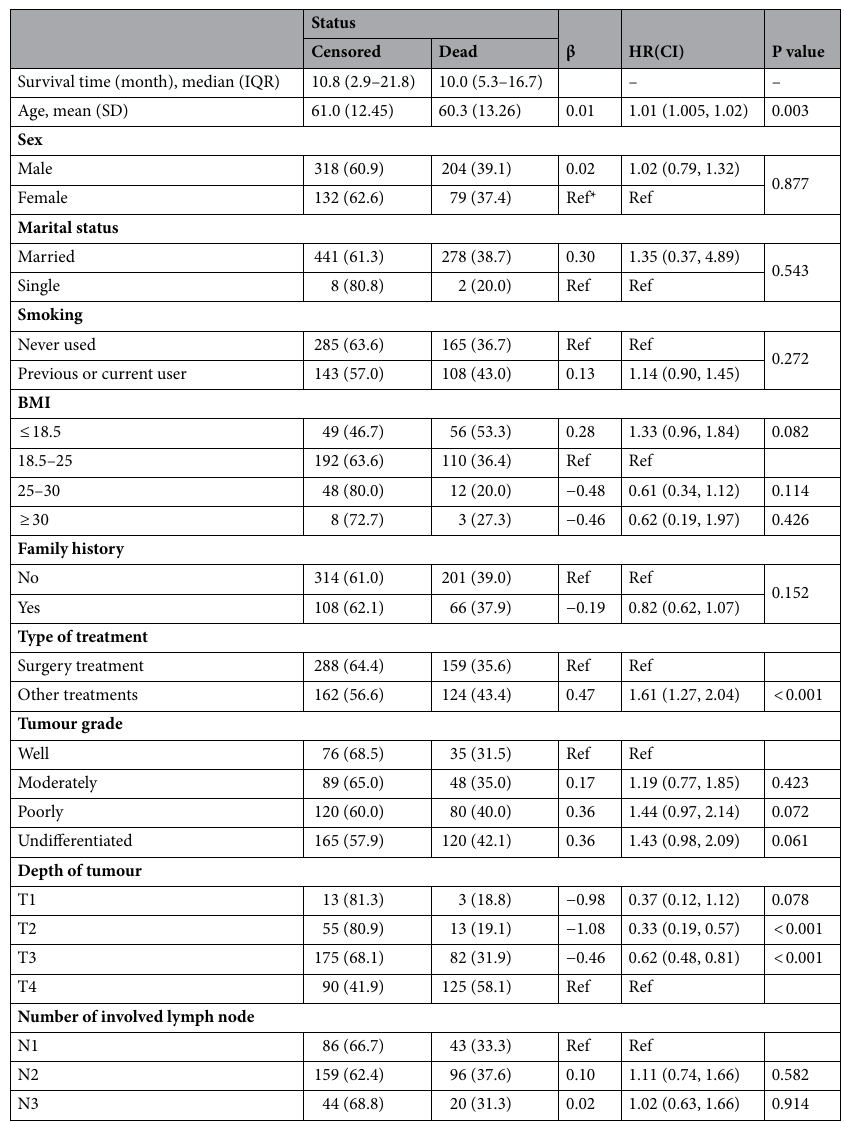
Table 1. Univariable Cox regression analyses for survival in patients with gastric cancer. * Ref :